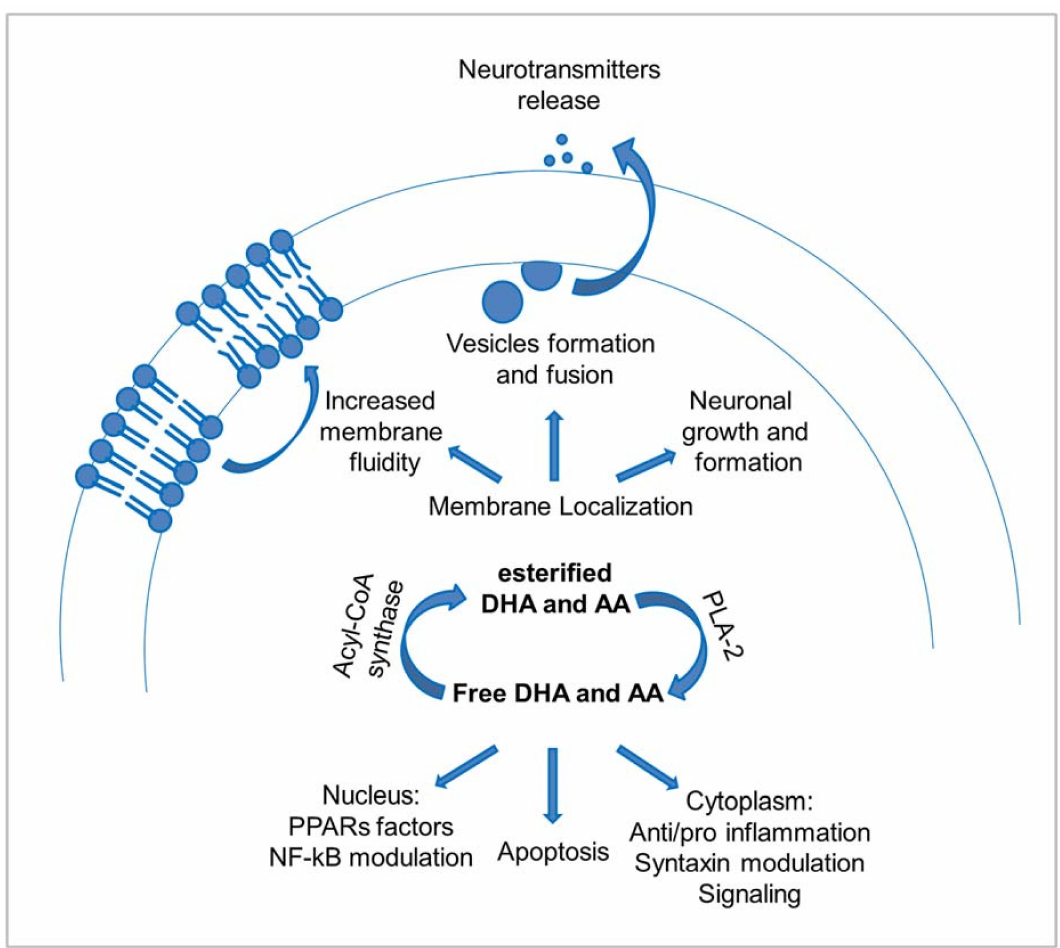
Figure 1. DHA and AA functions in neurons. Schematic representation of the different essential roles of DHA and AA and their metabolites, according to their esterified or free